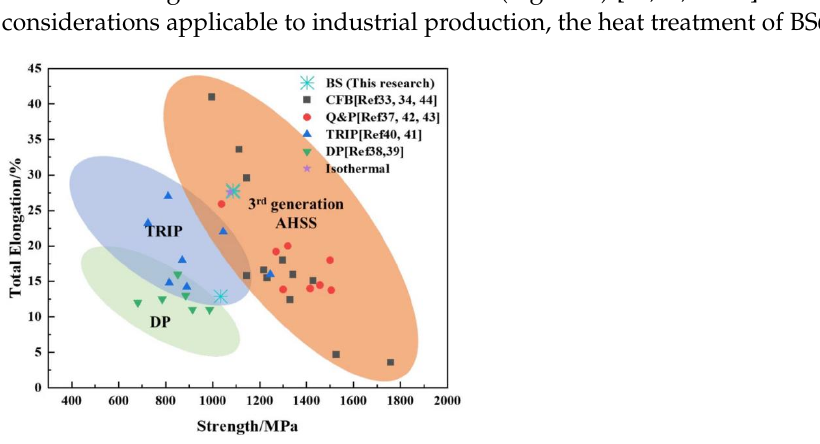
8 of 10 Figure 6. True stress–strain curves and work ‐ hardening rate curves for samples BS30, BS60, and BS120 ( a ), the volume fraction of austenite before and after deformation, measured by XRD and EBSD ( b ).